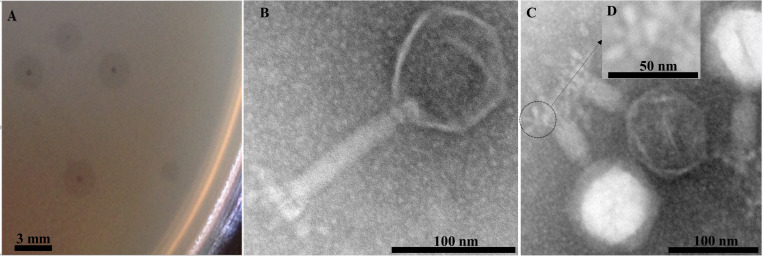
Plaques formed in the top agar layer (A), morphology of the extended tail phage EspM4VN (B), contracted tail phage EspM4VN (C), and displaying an umbrella-like structure (D). Bars indicate 3 mm (A), 100 nm (B,C), and 50 nm (D).